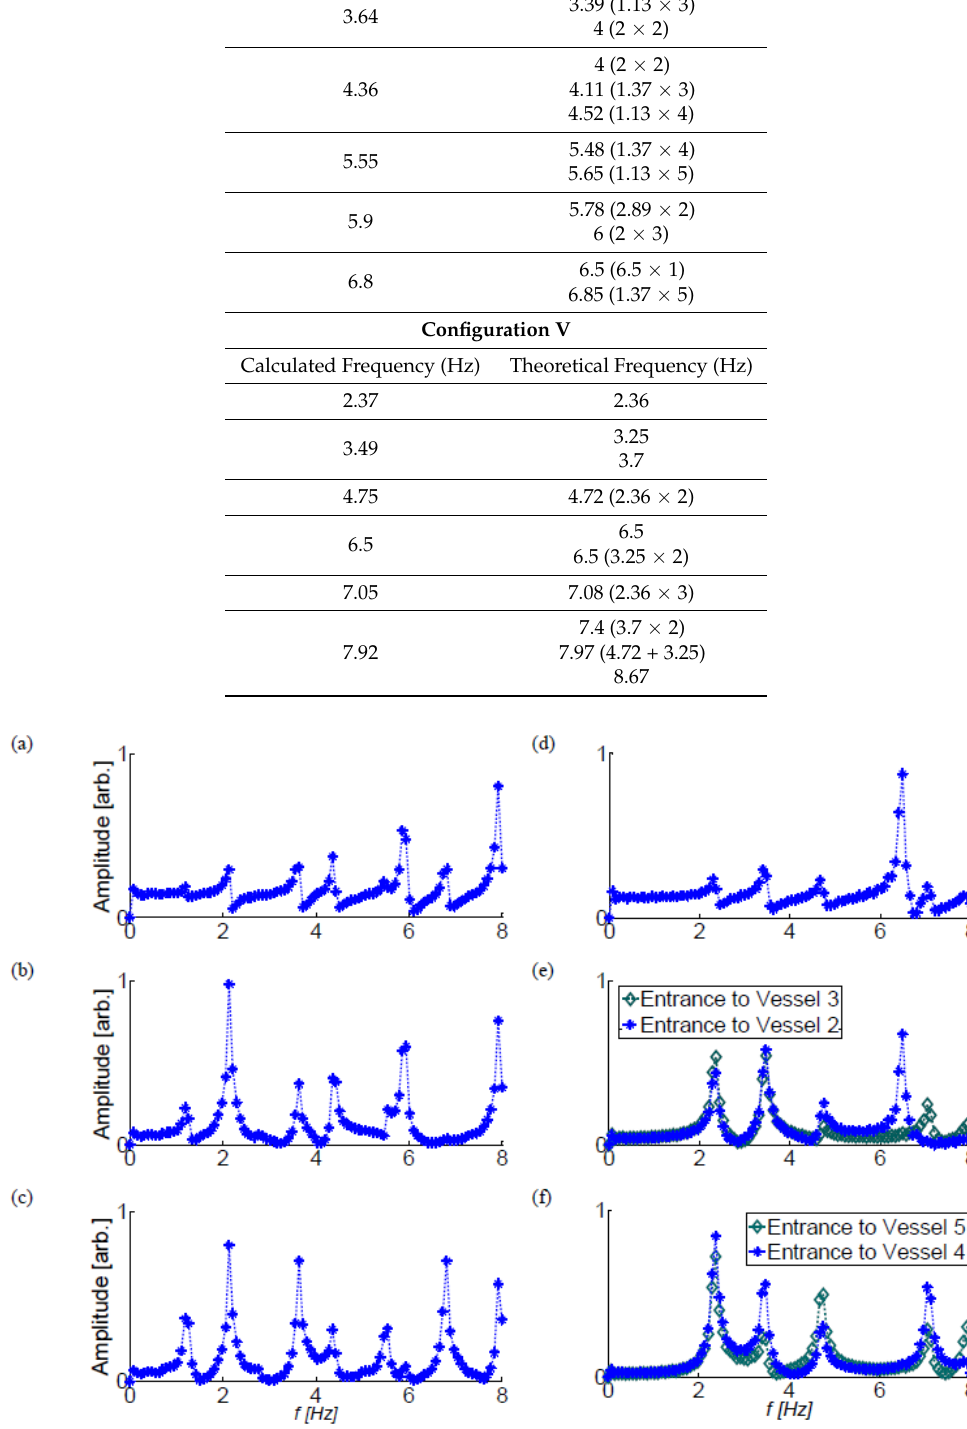
Figure 5. The dependence of NFR on the normalized actuation frequency for configuration III-a. The frequency is normalized by the first fundamental frequency of III-a, f 1 = 3.25 Hz. The actuator was located on the first vessel at / .